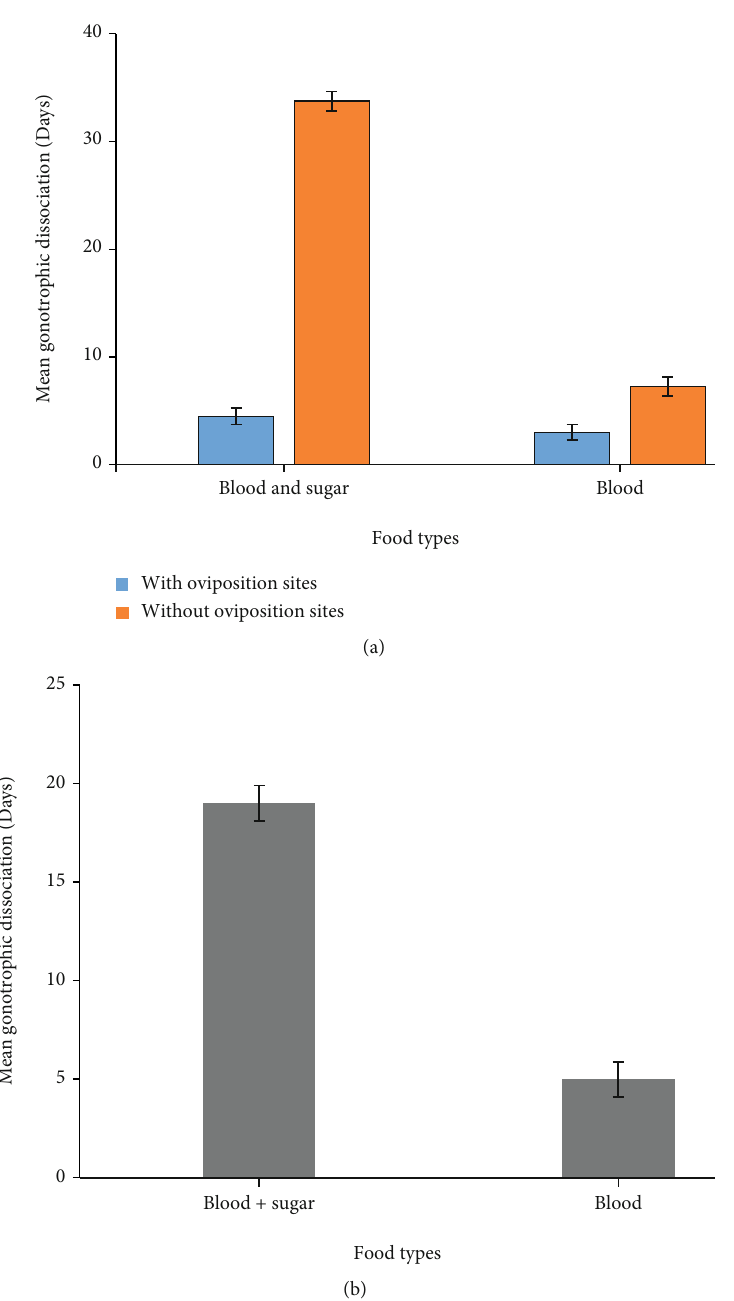
Figure 4: (a) The mean gonotrophic dissociation time of gravid An. gambiae s.s. fed on both blood and sugar and blood alone with or without oviposition deprivation. (b) The mean gonotrophic dissociation time of gravid An. gambiae s.s. fed on both blood and sugar and blood alone, with or without oviposition